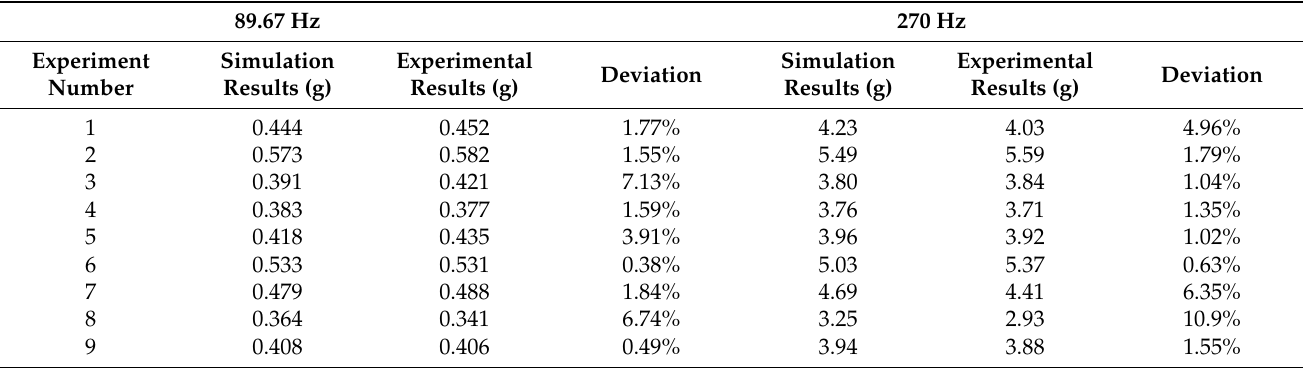
Table 14. Comparison of simulation results and experimental results for hard-coated straight aviation hydraulic pipes under basic fixed-frequency harmonic